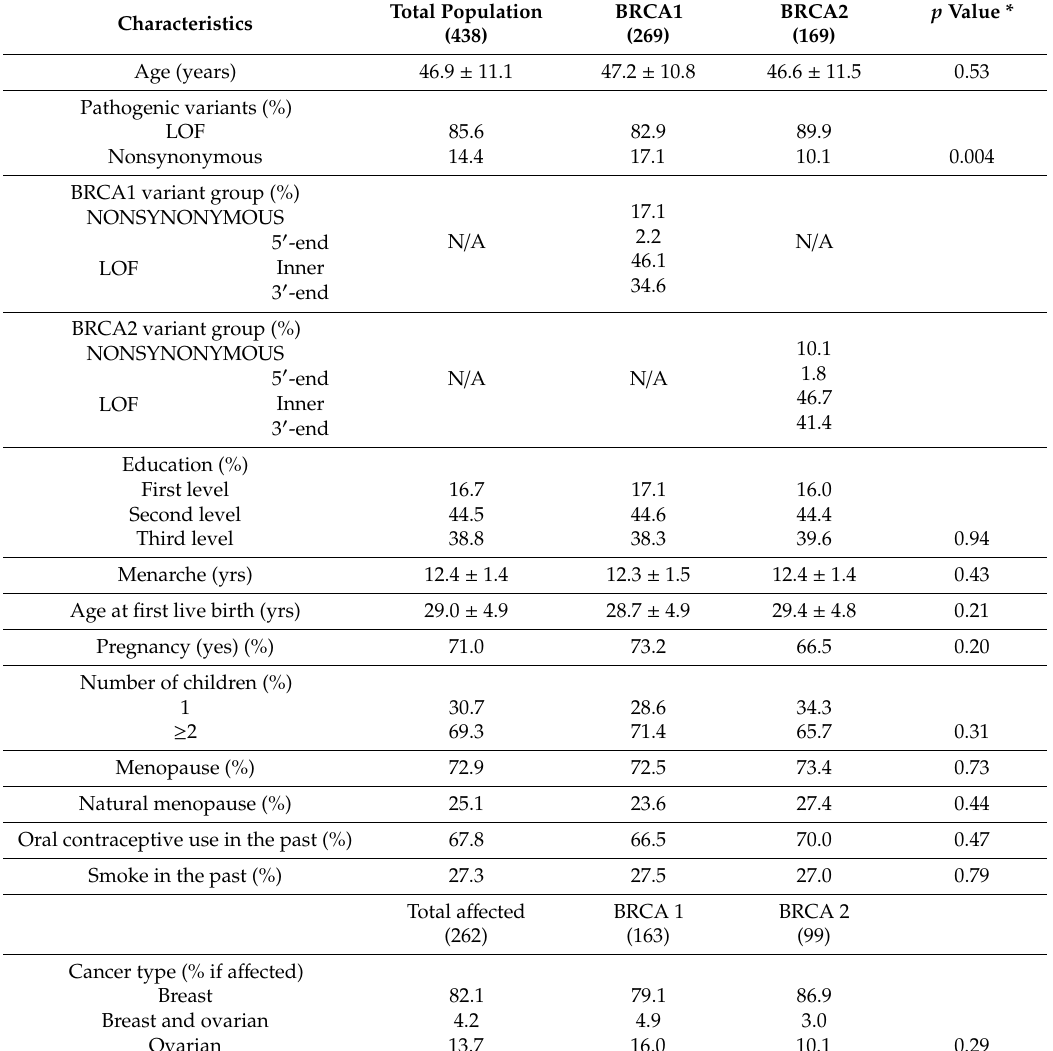
Table 1. Baseline characteristics of the study population by BRCA1 and BRCA2 genes ( BRCA1 / 2) in 438 female